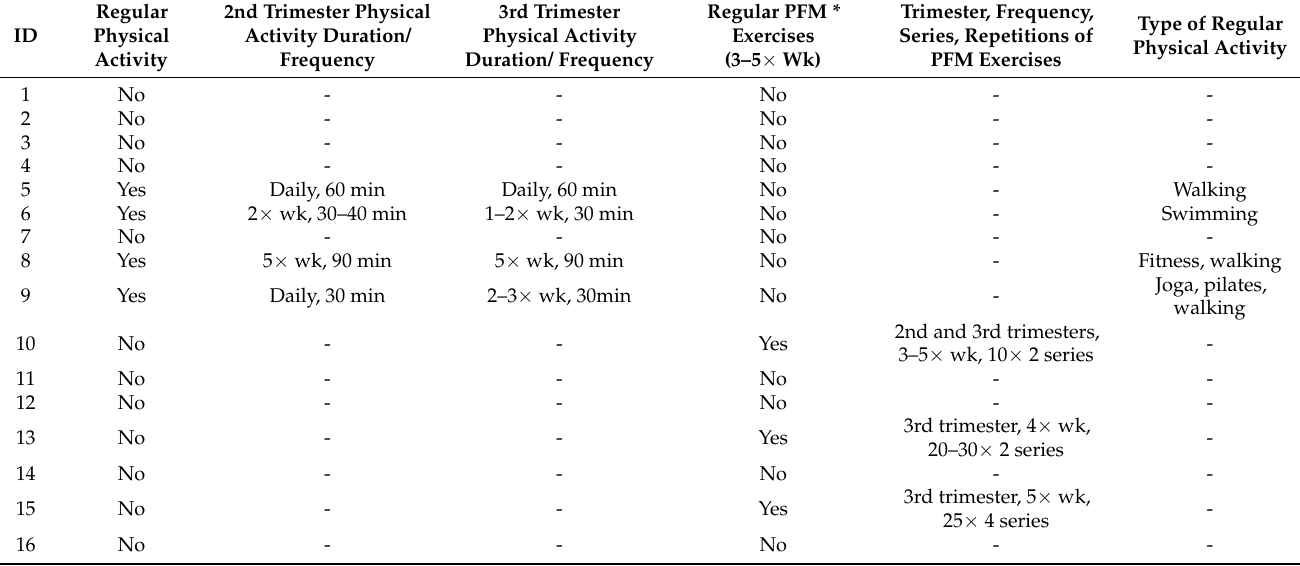
* Competitive-elite athlete regularly competes at the highest level (e.g., top divisions/leagues, the Olympic Games) without any achievements; successful-elite athlete competes at the highest level with some (infrequent) success (e.g., winning an event or a medal); world-class elite athlete experiences sustained success at the highest level, with repeated wins over a prolonged time (e.g., winning gold medals in consecutive Olympics, or major competitive victories over many seasons) [27]. Table 2. Regular prenatal, individual or organized, recreational physical activities (at least 30 min 2–3 × week) in non-athletes 1